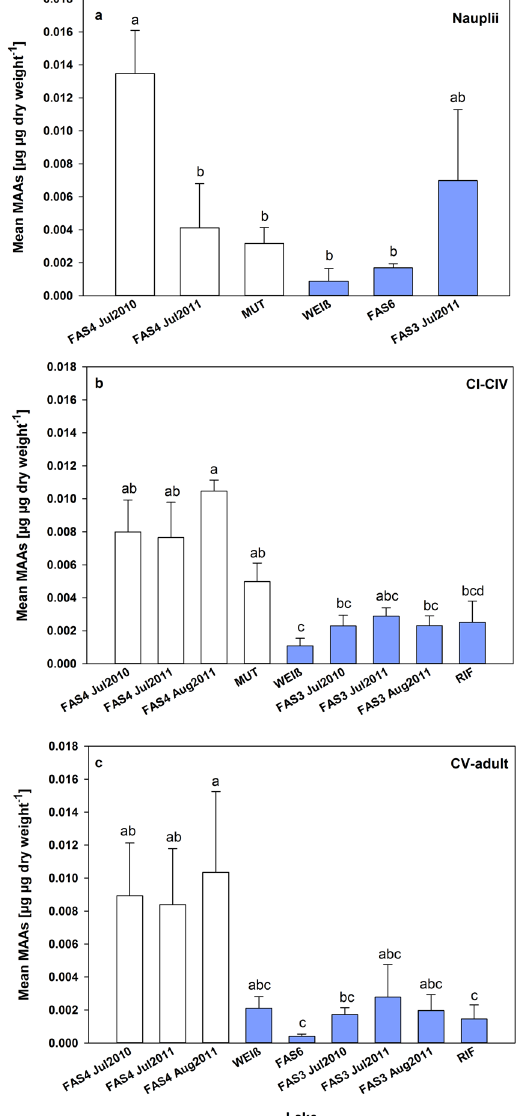
Figure 4. Total mean MAA concentrations ( µ g µ g dry weight − 1 ) in the different life stages nauplii, copepodid CI-CIV, and copepodid CV to adult of Cyclops abyssorum tatricus from six alpine lakes sampled during the ice- free period of 2010 and 2011. The lakes are ordered from clear to turbid (abbreviations for the lakes are defined in Table 1). Error bars indicate + 1 standard deviation. Different letters above the bars indicate a significant difference found with one-way ANOVA all pairwise comparison procedures (Holm-Sidak method, F 5,12 = 11.36, p < 0.001 for nauplii), and Kruskal-Wallis one-way ANOVA on Ranks, all pairwise multiple comparison procedures (Dunn’s method, p < 0.05 for CI-CIV and CV-adult). White bars: clear lakes, blue bars: turbid lakes. Nauplii were not present in all lakes at the time of sampling. Copepodid CI-CIV and CV-adult were not present in Lakes FAS6 and MUT, respectively, at the time of